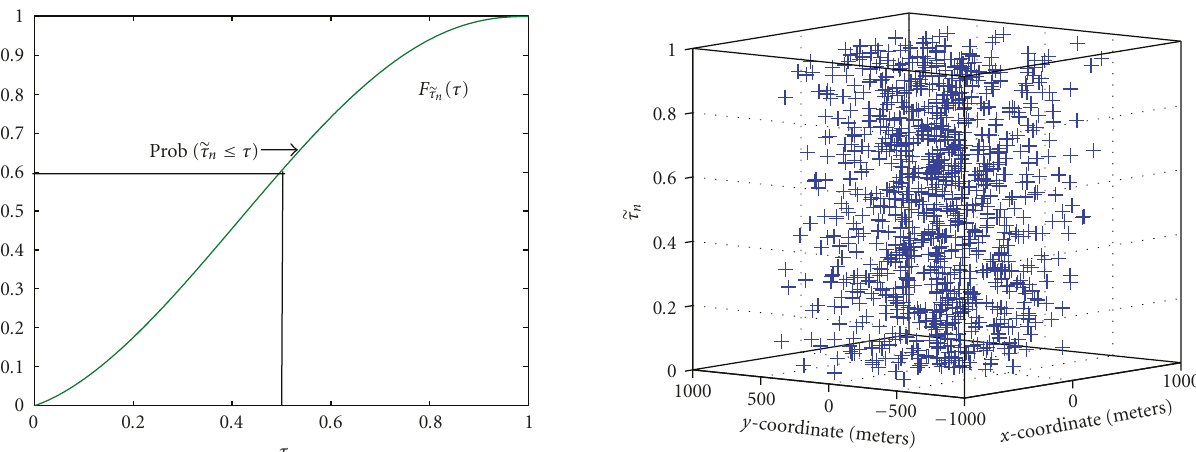
Figure 13: CDF of (cid:9) τ n , F (cid:9) τ ( τ ) in DVD for v min = 0 . 01m/s. n